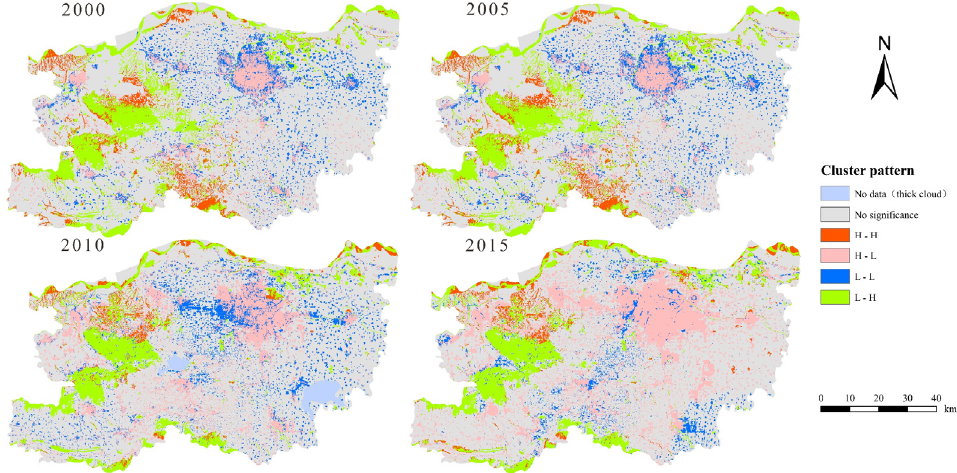
Figure 8. LISA cluster map of LST and habitat quality during the different periods from 2000– 2015.